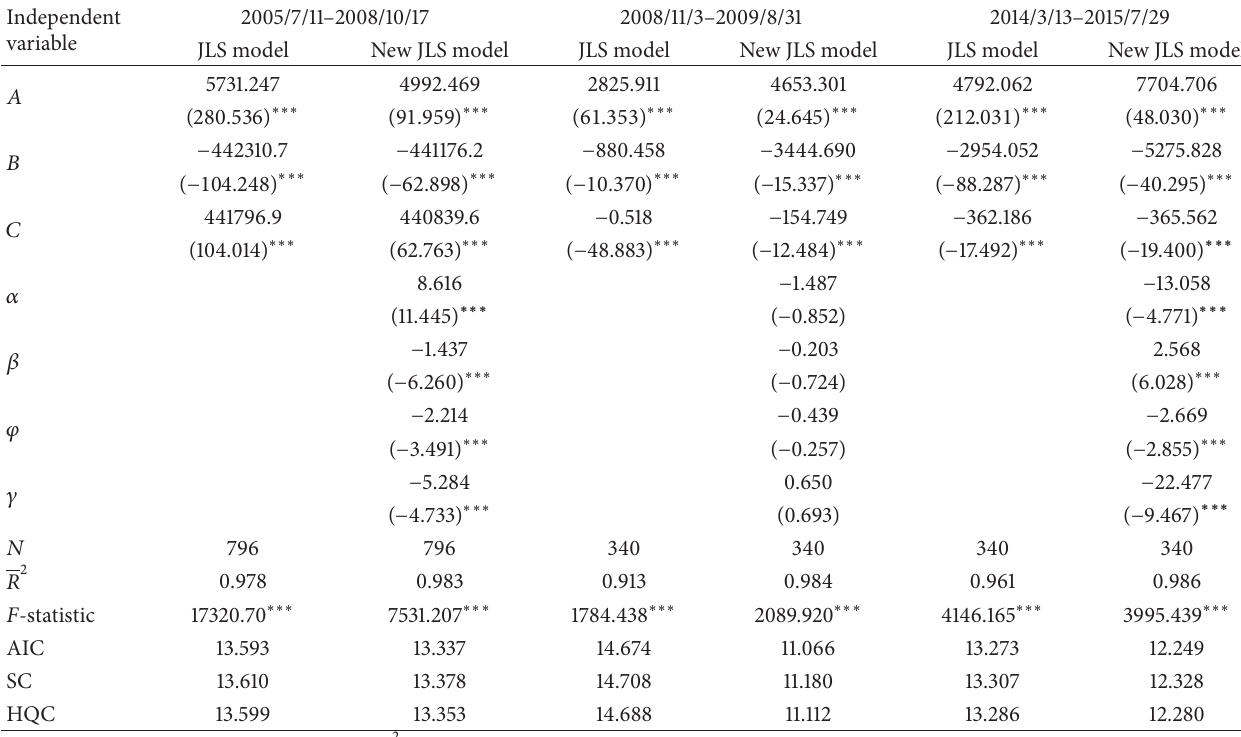
Table 5: The significance test results of the new and the original JLS model for the SSEC bubbles.